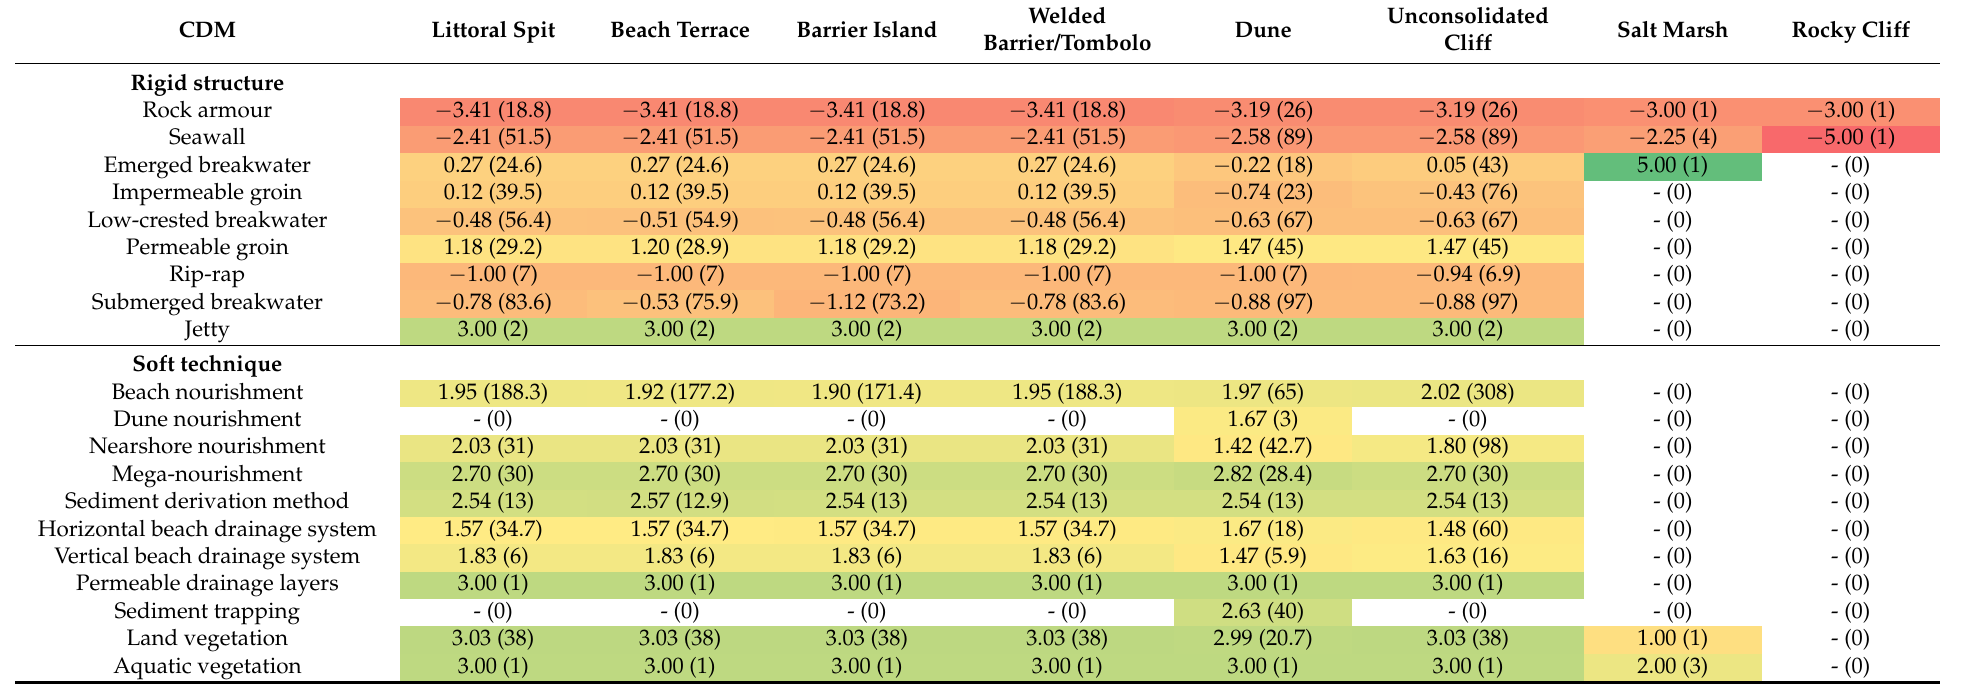
Table 13. Averaging of weighted average values of CDM effects by type of coast. Average nb.OE is written between brackets (avg. nb.OE)). CDM Littoral Spit Beach Terrace Barrier Island